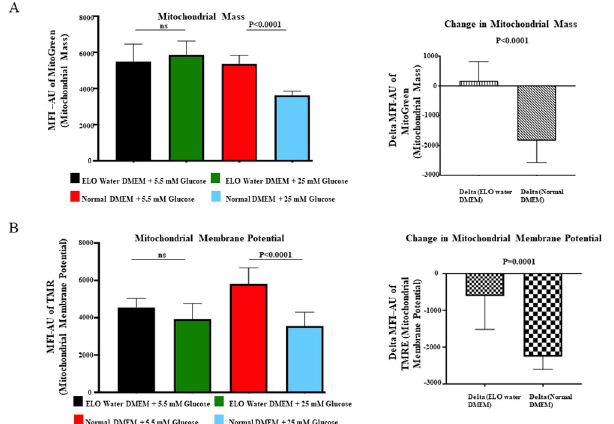
Fig 5. Delta changes of Mean Florescence Intensity (MFI) in mitochondrial mass determined by MitoTracker Green (A) and mitochondrial membrane potential by TMRE labelling (B) in HepG2 cells cultured in ELO water- based DMEM or control (regular) water-based DMEM in glucose environments of normal (5.5 mM) or high (25 mM) glucose concentrations over 14 days. The MFI, expressed in arbitrary units (AU), was used to represent the metric of MitoTracker and TMRE. Biological replicates (N = 3), Technical replicates (n = 3).